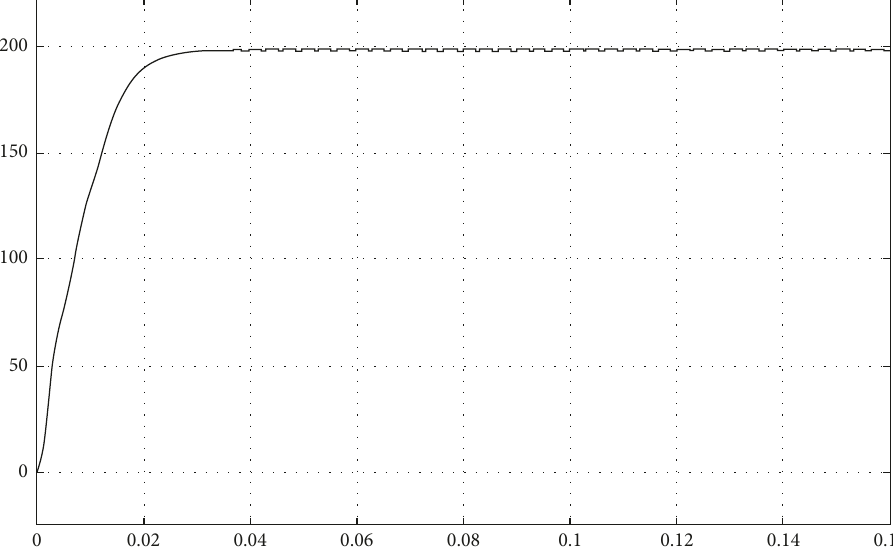
Figure 9: Output current waveform.